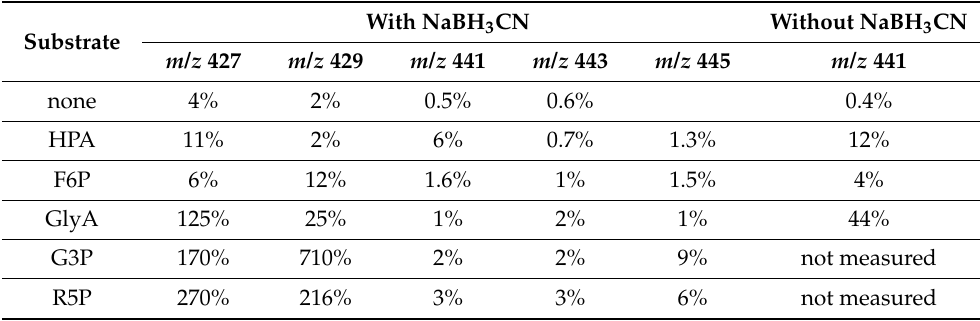
Table 1. Amplitudes of ThDP intermediates relative to amplitude of ThDP in MS spectra. Data from Apex